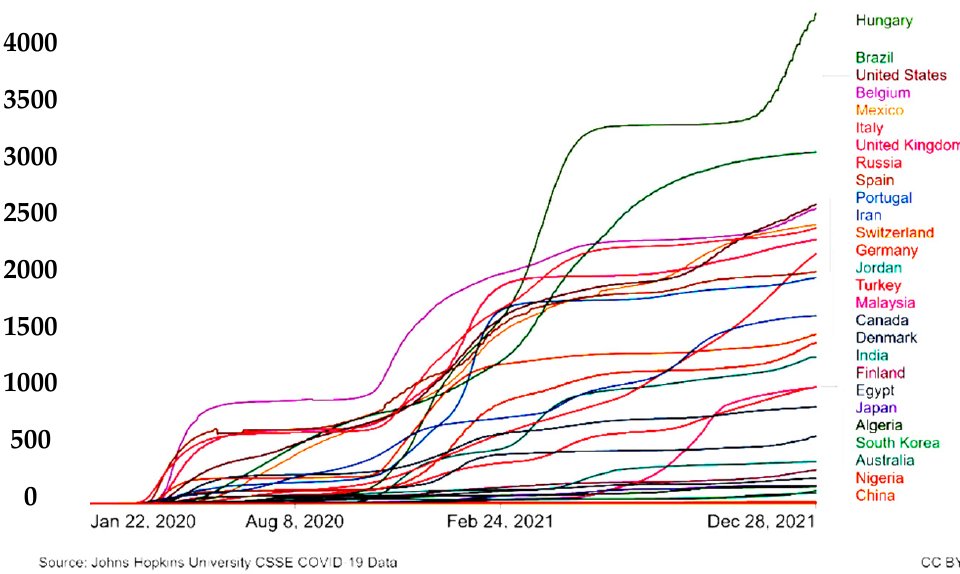
Figure 3. The daily confirmed COVID-19 deaths per million people in the studied countries.